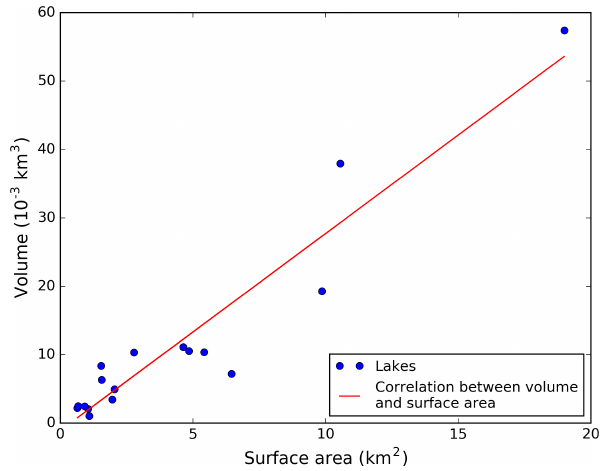
Figure 7. A strong correlation exists between surface area and mod- eled volume for the 17 lakes we analyzed.